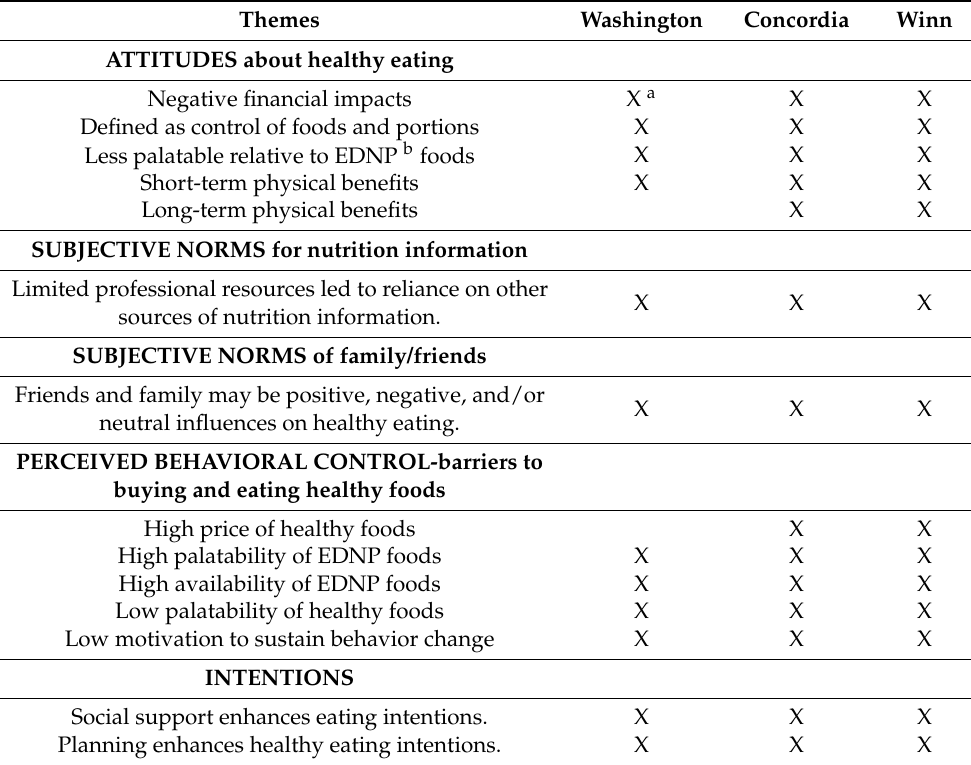
Table 2. Cross-case analysis of qualitative themes related to healthy eating in three rural, low-income Louisiana